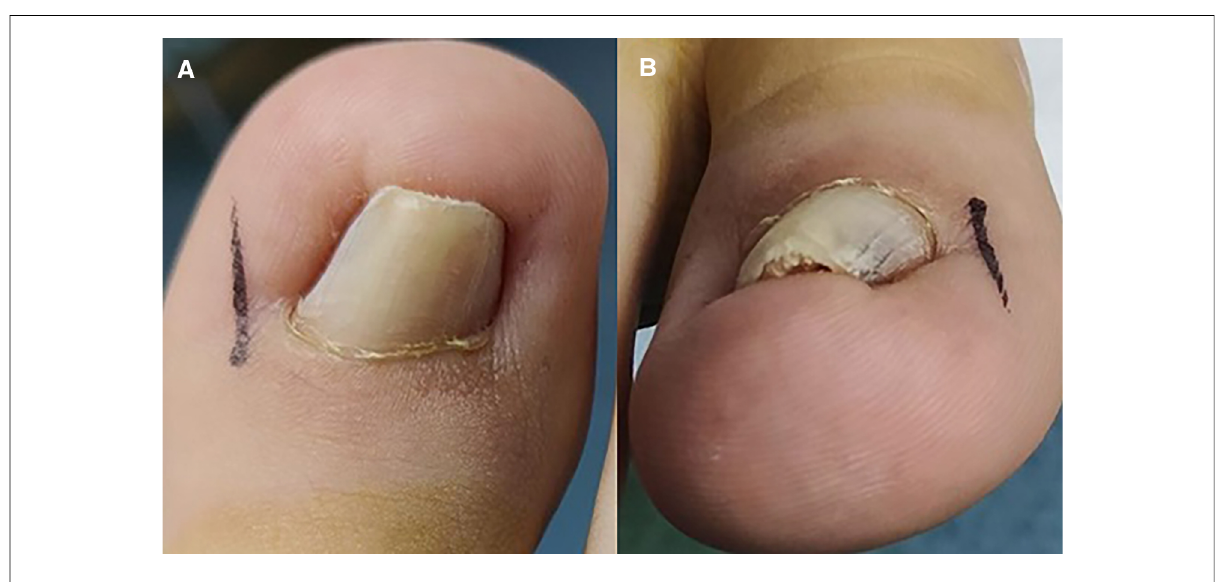
FIGURE 1 Preoperative appearance of affected great toenails at different angles ( A,B ).